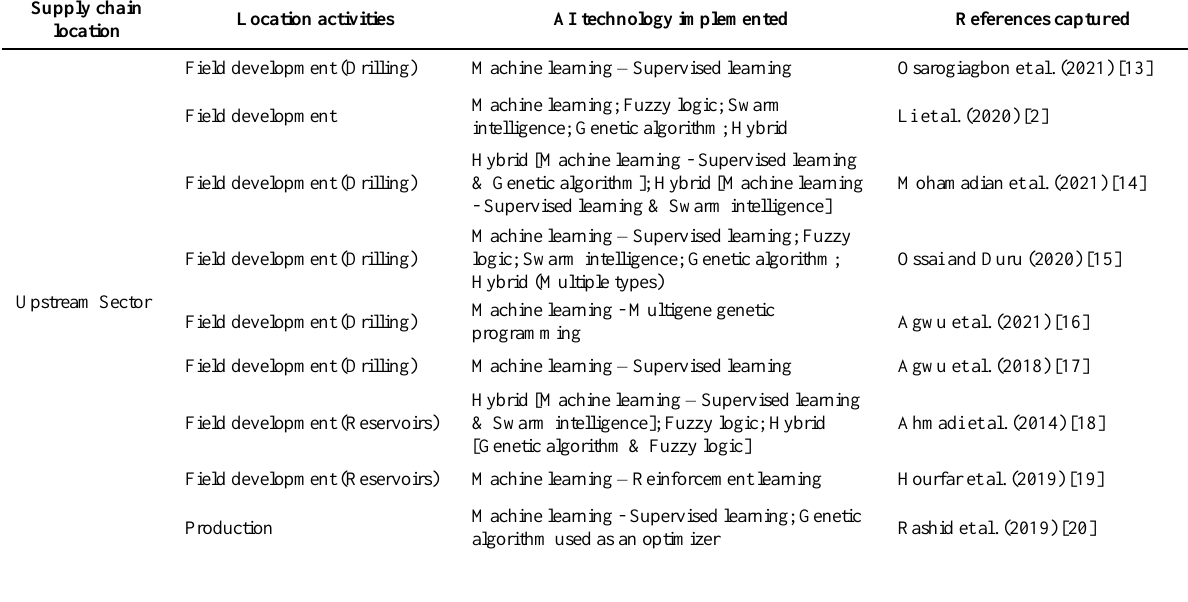
Table 1. Papers focusing on AI technologies applied to upstream